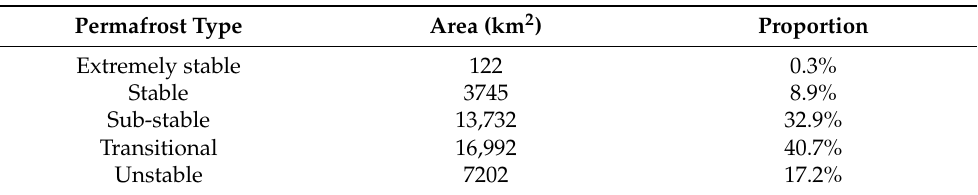
Table 2. Area statistics table of different stability types of permafrost in the area with linear subsidence rate greater than 10 mm/yr. Permafrost Type Area (km 2 ) Proportion Extremely stable 122 0.3% Stable Sub-stable 13,732 32.9% Transitional 16,992 40.7% Unstable 7202